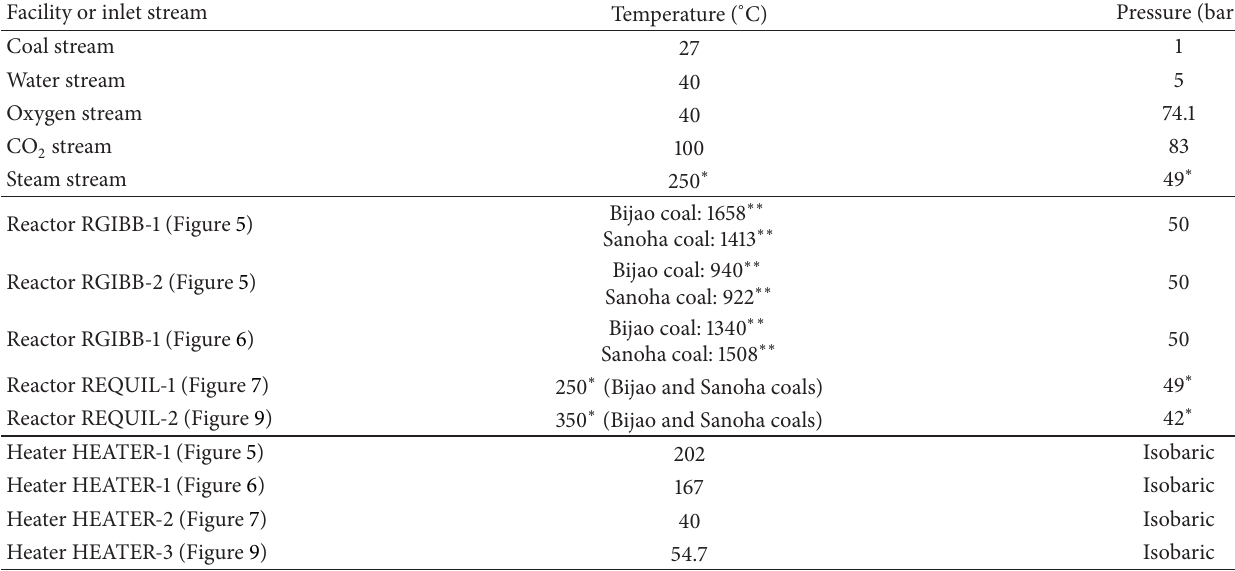
Table 4: Reactors temperature and pressure conditions, inlet streams, and other model facilities described in the Aspen Plus models. Facility or inlet